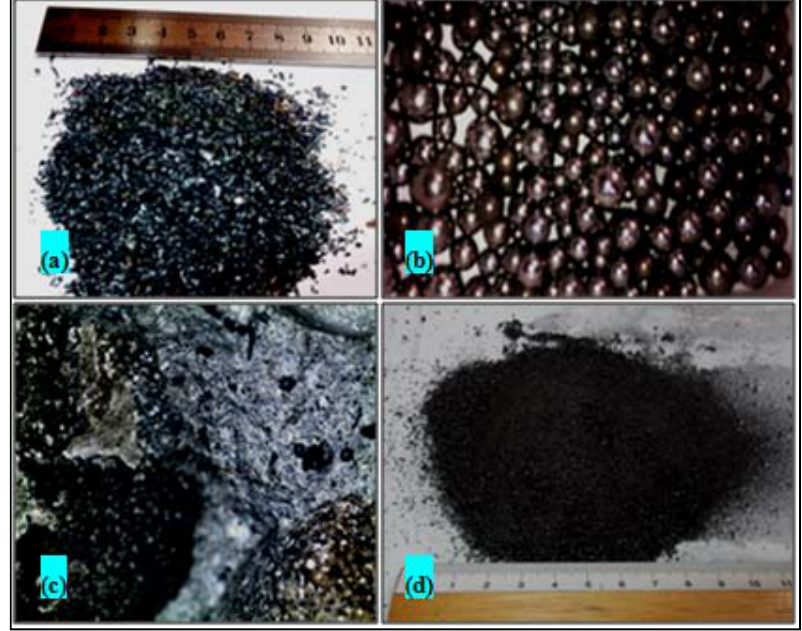
Figure1. Low magnification optical graphs of the metal particulates and the steel slags used in this study: ( a ) Iron particulates from abrasives machining of steel; ( b ) Steel balls